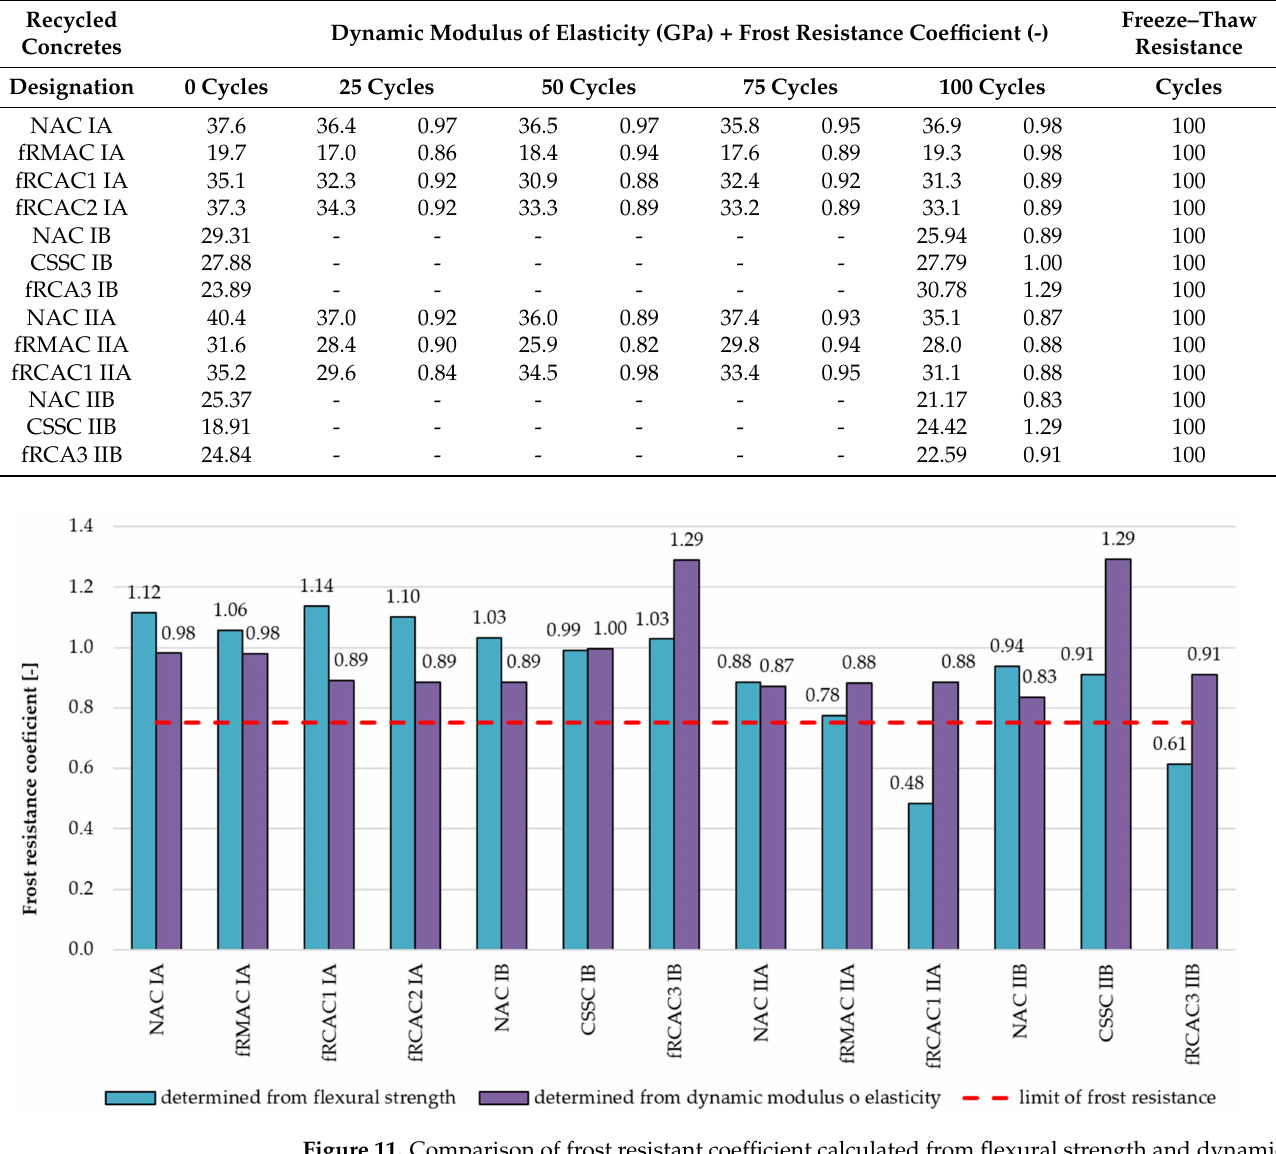
Table 9. Dynamic modulus of elasticity after freezing and thawing.